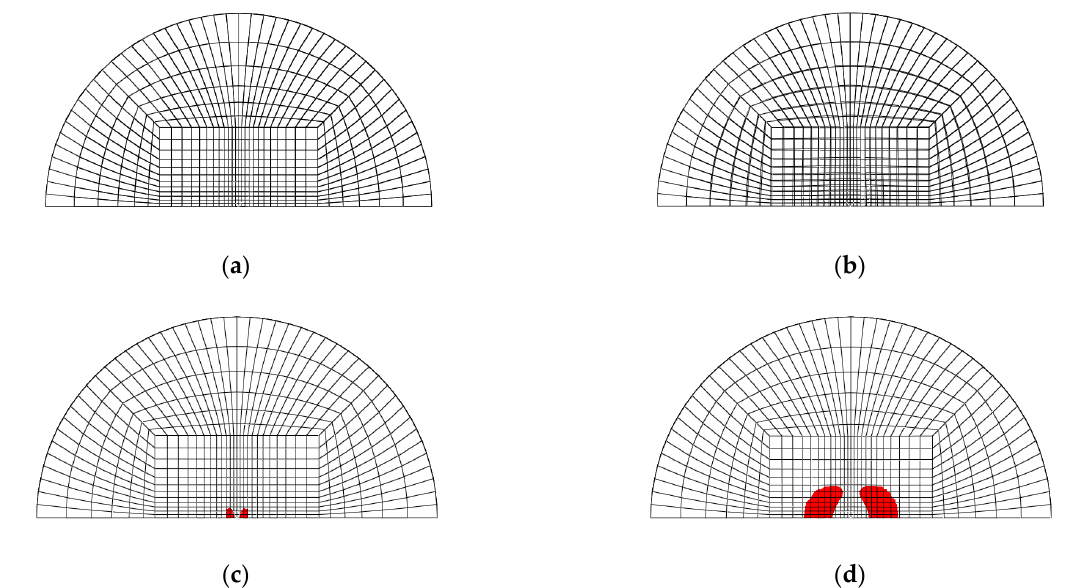
Figure 20. Fiber tension failure (FTF) in the composite layers of GLARE 5-2/1 with [0 ◦ /90 ◦ /90 ◦ /0 ◦ ] after applying the first impact energy of 8 J; ( a ) 2D failure model (0.392 ms), ( b ) 2D failure model (3.66 ms), ( c ) 3D failure model (0.392 ms); ( d ) 3D failure model (3.66 ms).